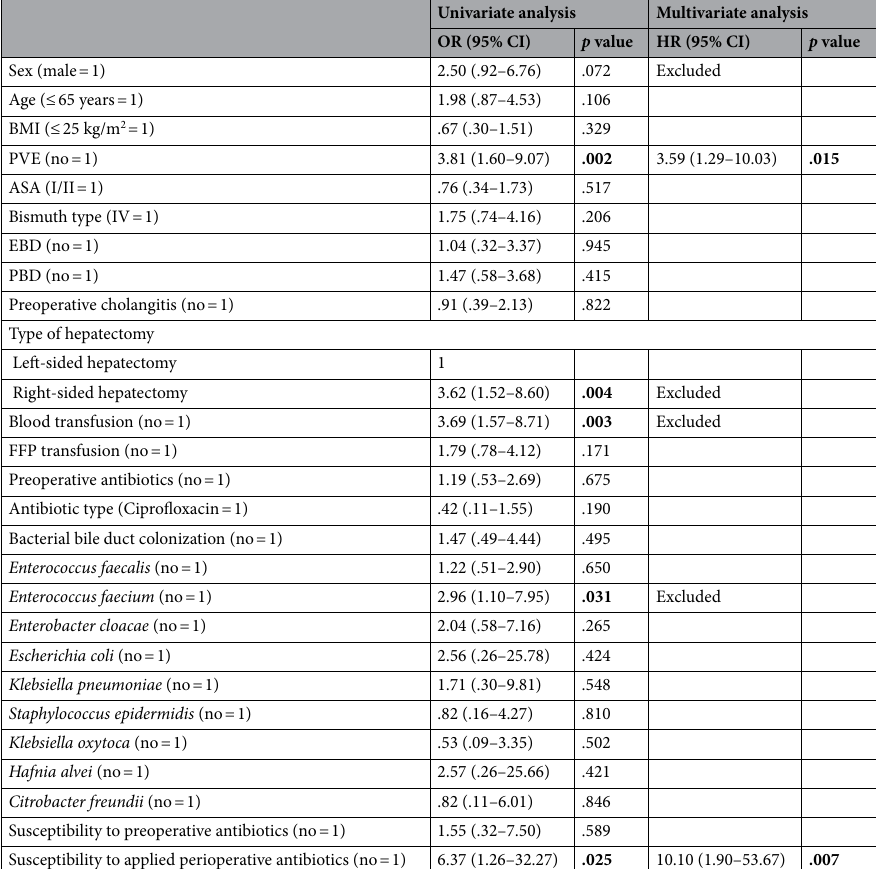
Table 4. Univariate and multivariable analysis of postoperative abdominal infections. Various parameters are associated with postoperative abdominal infections. Bold indicates statistical significance ( p < 0.05). ASA American society of anesthesiologists classification, BMI body mass index, EBD endoscopic biliary drainage, PBD percutaneous biliary drainage, PVE portal vein